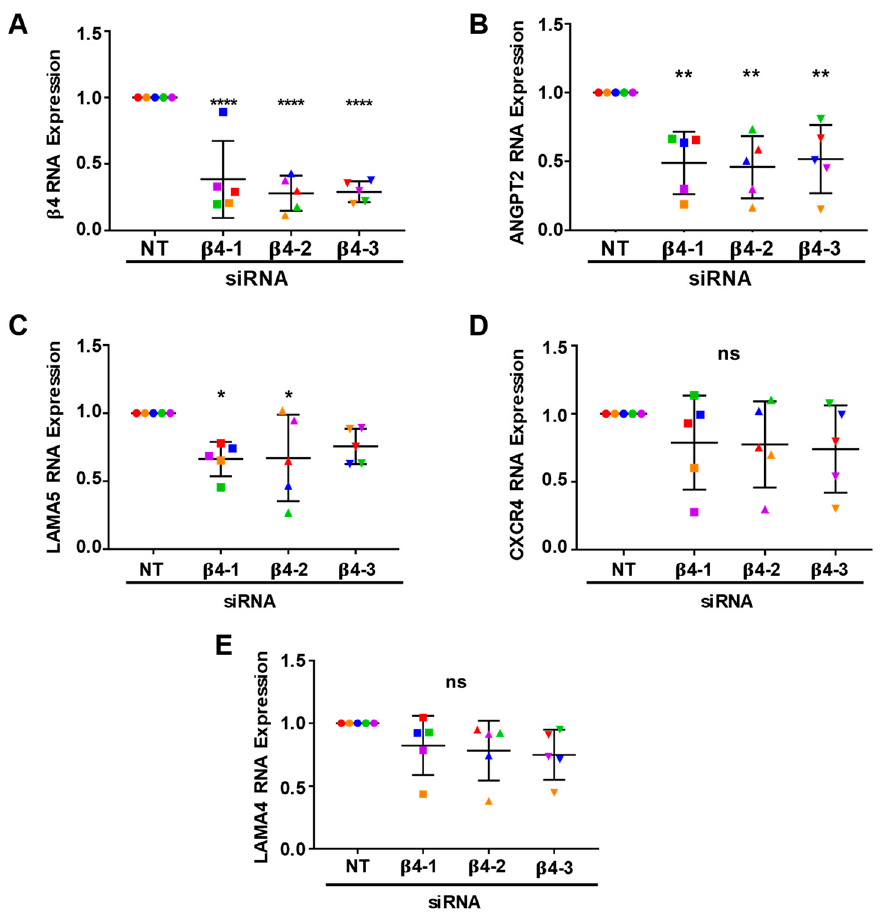
Figure 4. The expression ANGPT2 is positively regulated by integrin α 6 β 4. RNA was isolated from 6-day bead sprouts and analyzed by qPCR: ( A ) Shown is the efficiency of β 4 depletion using three distinct siRNA targeting sequences (also shown in Figure 2A) and the effects of β 4 depletion on the expression of the ( B ) ANGPT2, ( C ) LAMA5, ( D ) CXCR4, and ( E ) LAMA4. Data were normalized to β -actin and then to the non-targeting (NT) control. Plotted is the mean RNA expression ± s.d. n = 5 independent experiments. Data were analyzed using a Single-Sample t-test. Each independent experiment is represented by a different color. ns = not significant, * p ≤ 0.05, ** p ≤ 0.01, **** p ≤ 0.0001.